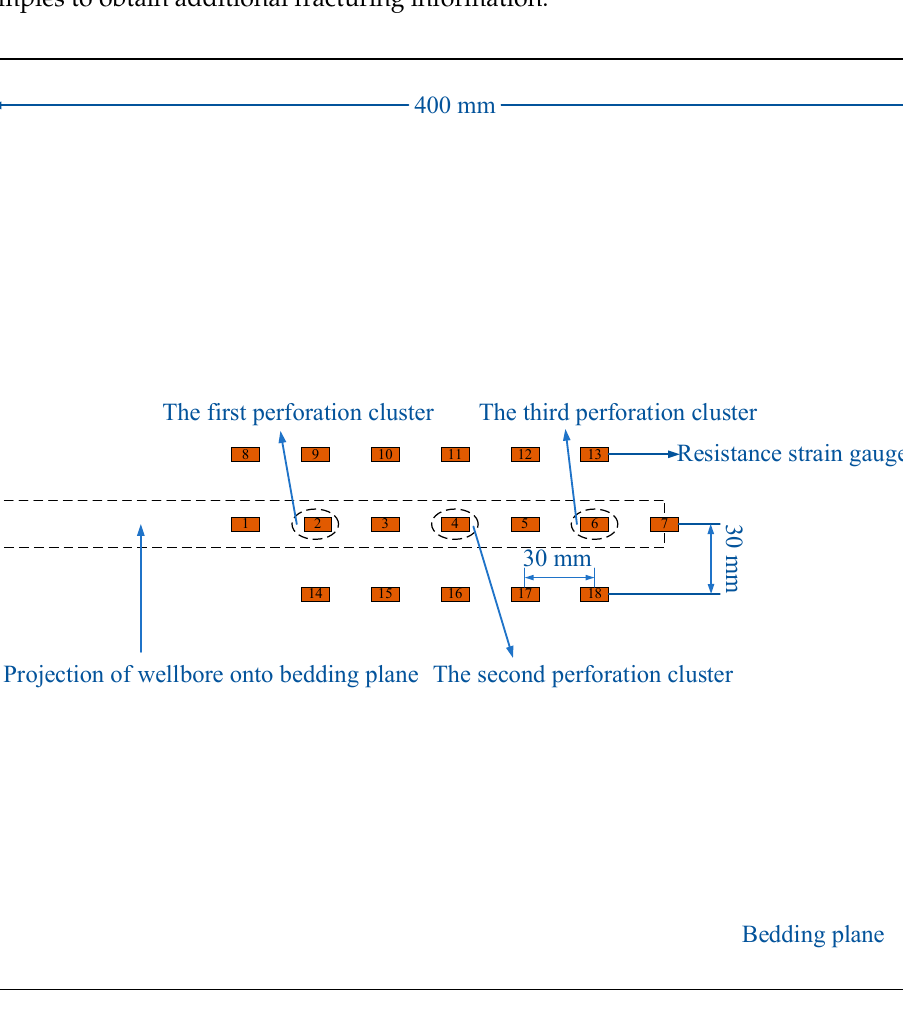
Figure 9. Arrangement pattern of resistance strain gauges (cluster spacing of 60 mm).